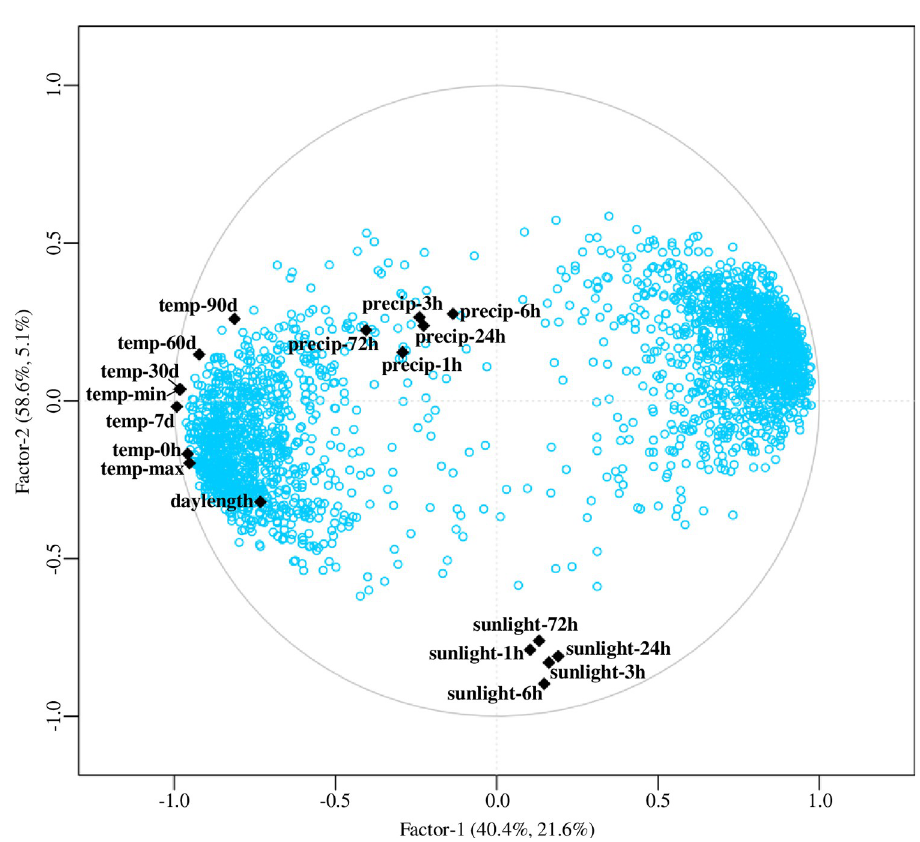
Fig 5. Relationship between various environmental factors and the expression of 2,505 targets exhibiting seasonal differential expression patterns between sites. Shown is a PLSR correlation-loadings plot of factor 1 versus factor 2, modeled by environmental factors (black rhombi) in the X-matrix and target expression levels (blue dots) in the Y- matrix. The first two PLS components describe 62.1% and 63.7% of the variation in the predictor variables and response variables, respectively.